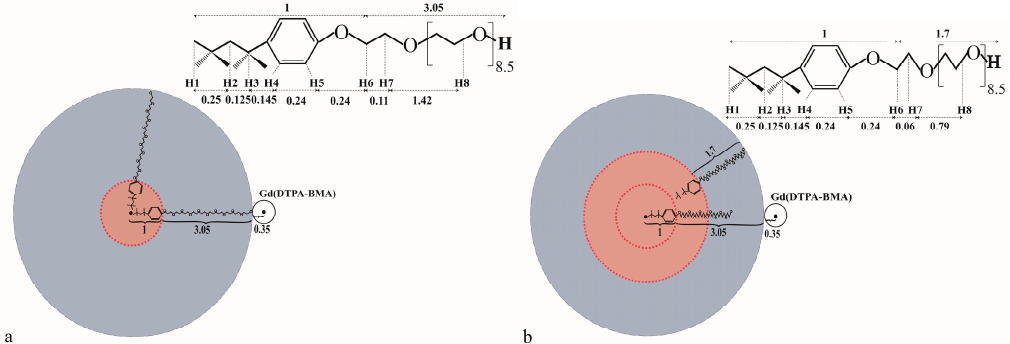
Figure 4. The simplified diagram of the one- ( a ) and two-layer ( b ) aggregated spherical micelle model of TX100; the distances (nm) between some important groups have been marked to clarify the analysis mentioned in the manuscript.